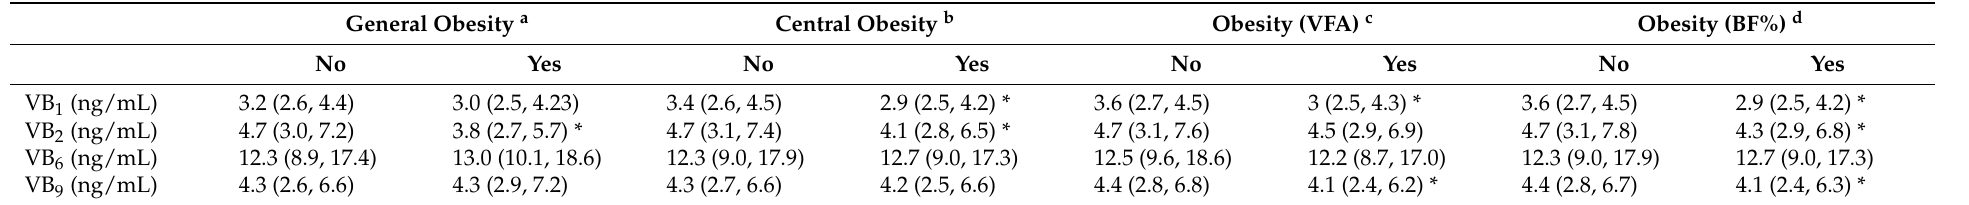
Table 3. Median Vitamin B concentration under different definitions of obesity (ng/mL) (M (P25, P75)). General Obesity a Central Obesity b